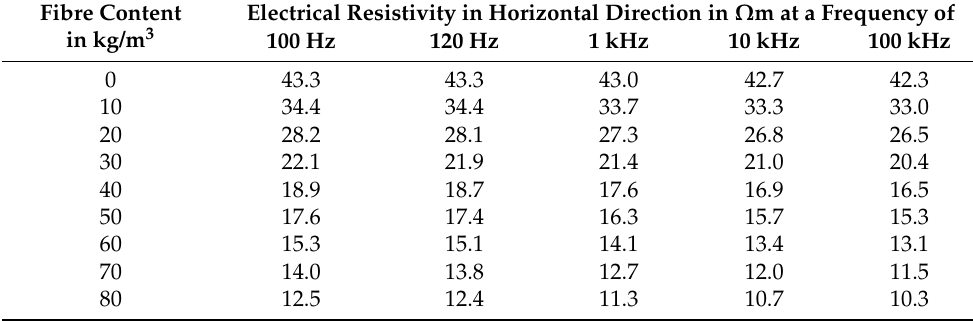
Table A22. Results of the resistivity measurements of the concrete mixture 32-60-300-00-F2. Fibre Content